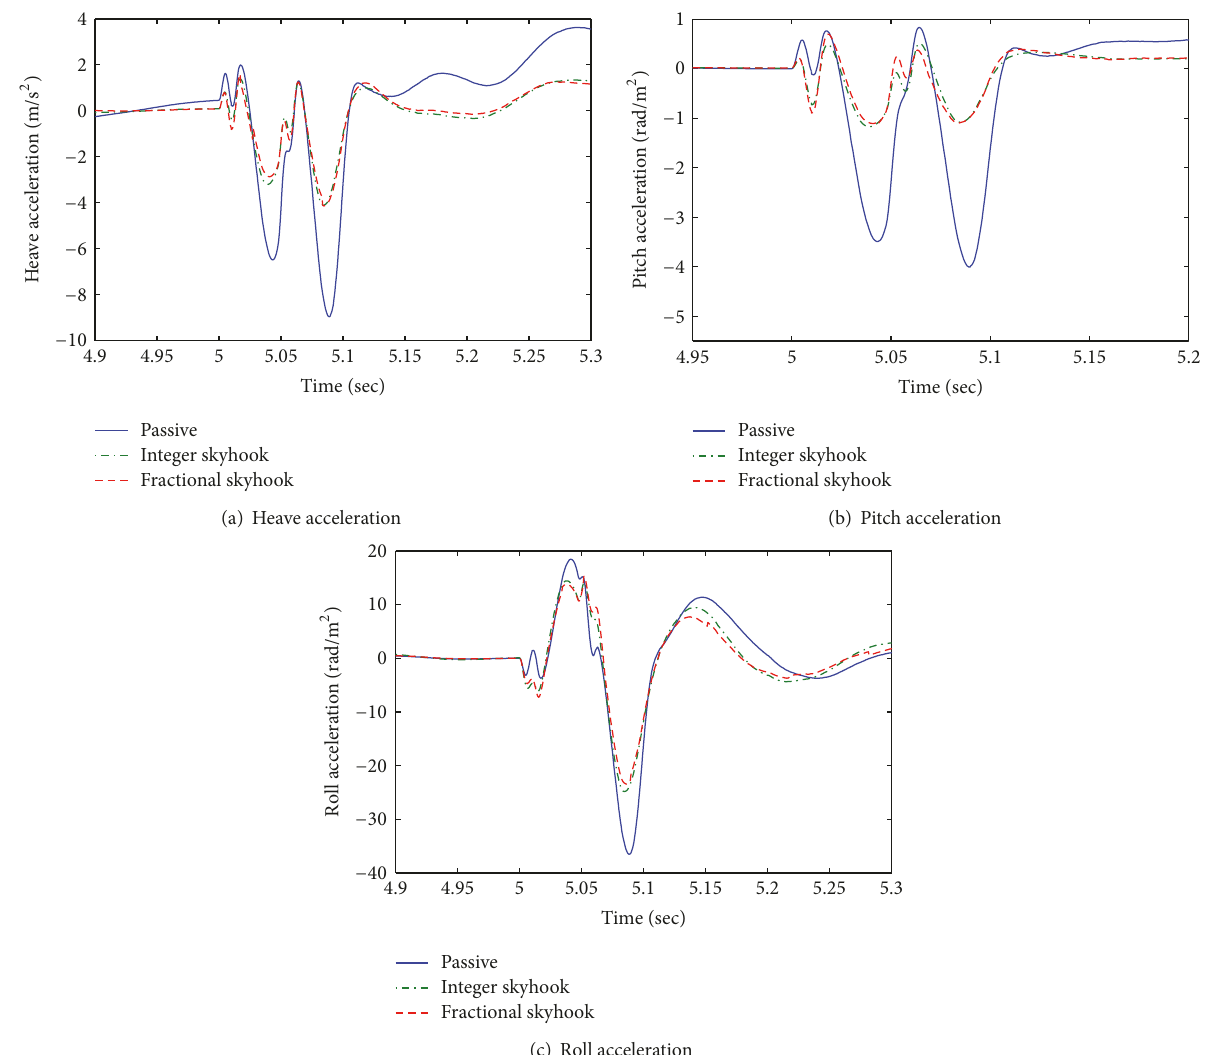
Figure 7: Body motion acceleration response of three kinds of